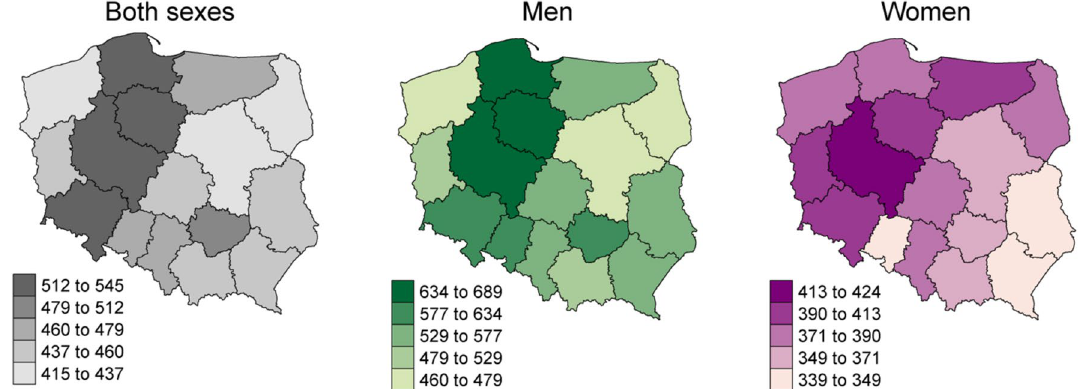
Figure 1. Age-standardized (ESP2013) incidence rates per 100,000 for all cancer sites aggregated, by sex— Poland, 2019.